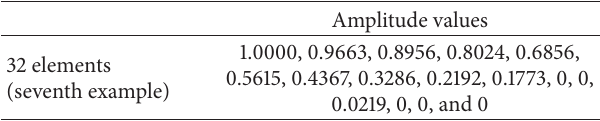
Table 6: MSL, DRR, and FNBW values obtained by obtained by DS and FA [32]. Table 7: Corrected amplitude weights obtained by DS.